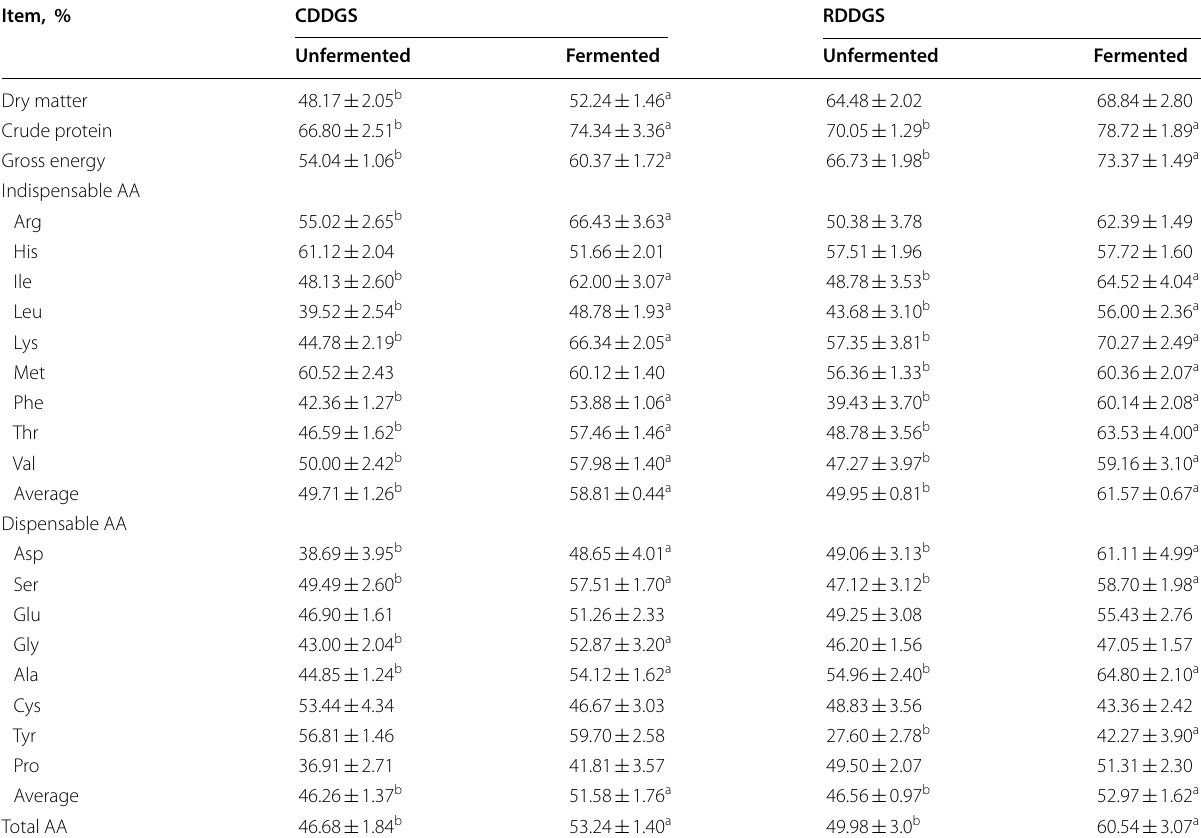
Values are means of three replicates per treatment. Means in a row without common superscript differ significantly ( P < 0.05)